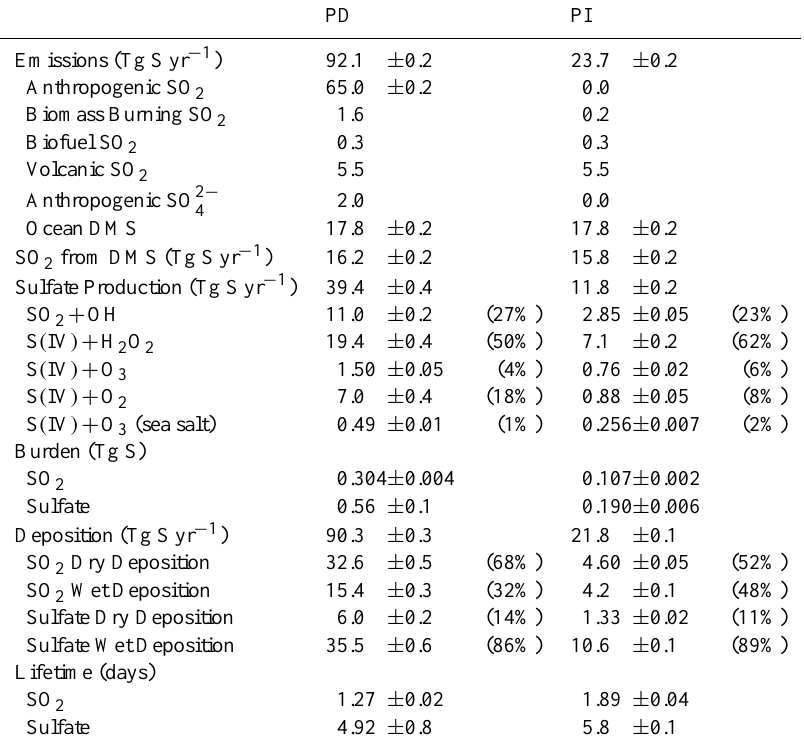
Table 1. Global annual (ten-year) average sulfur budgets for PD and PI. Uncertainties represent one standard deviation of the ten one-year annual budgets. Parentheses indicate the fraction of sulfate production, SO 2 deposition, and sulfate deposition associated with a particular